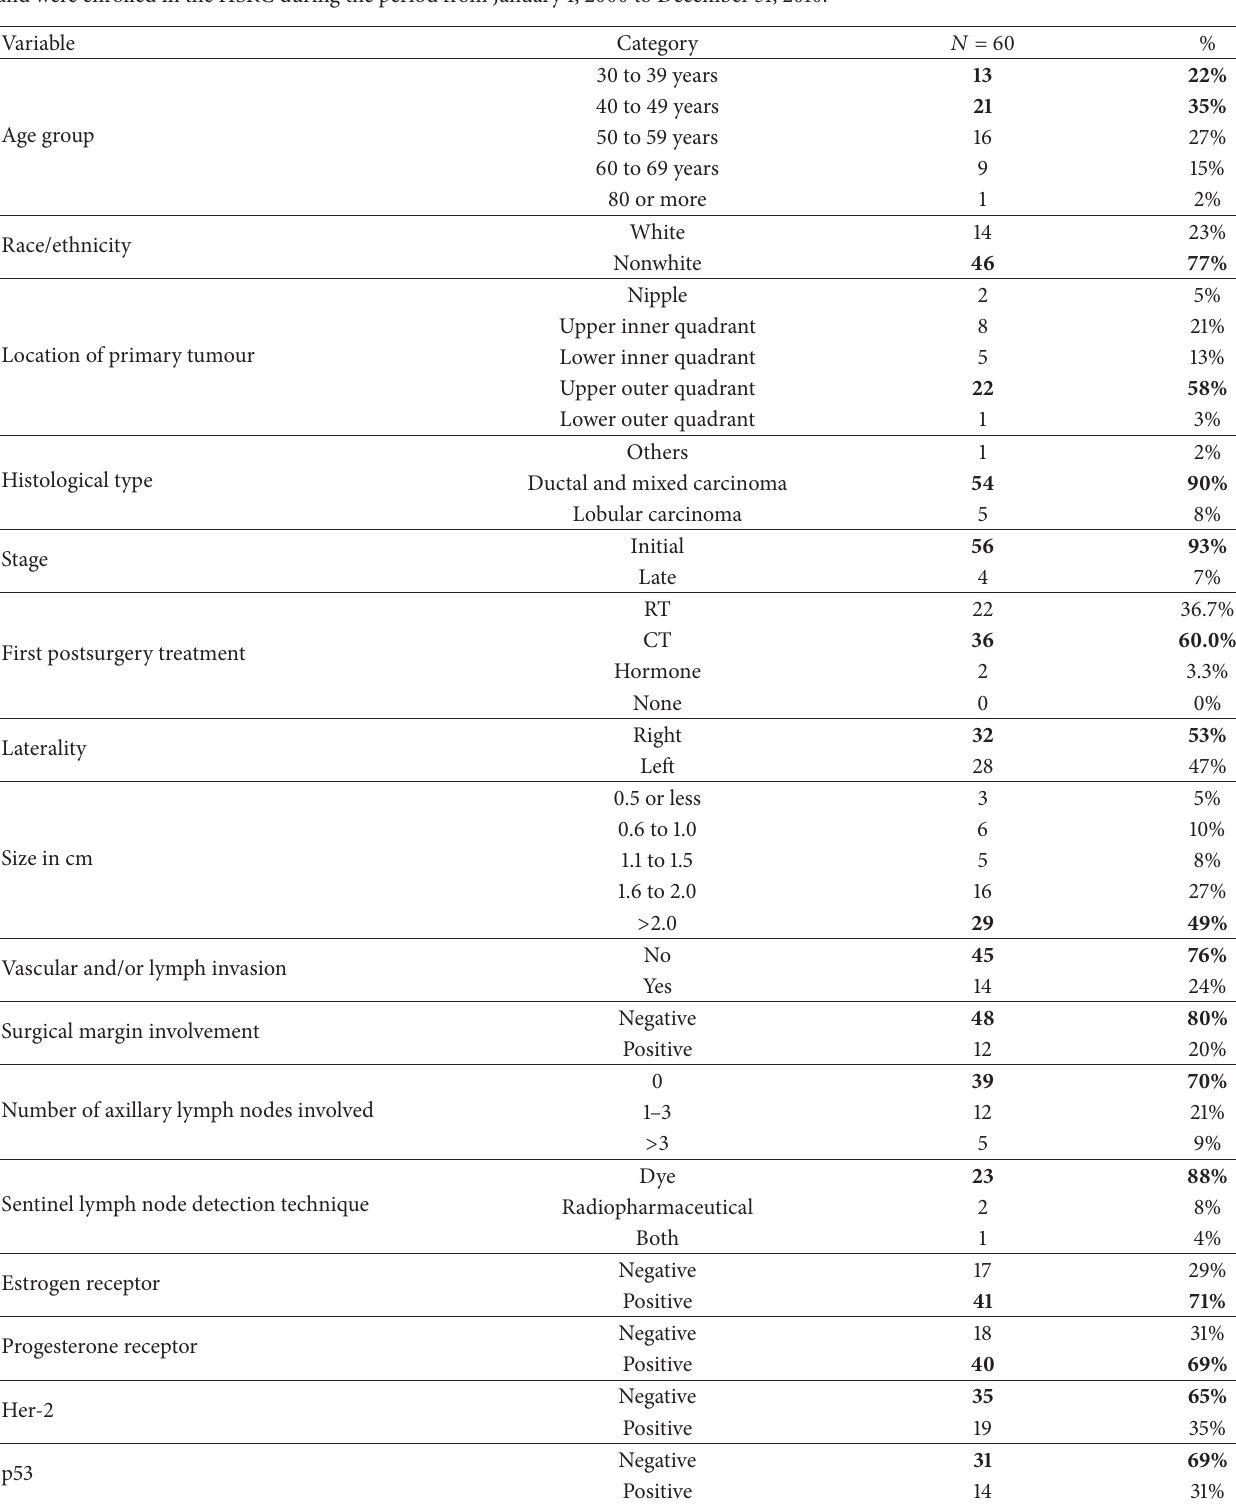
Table 1: Sociodemographic and clinical characterisation of women with recurrent breast cancer who underwent breast-conserving surgery and were enrolled in the HSRC during the period from January 1, 2000 to December 31,